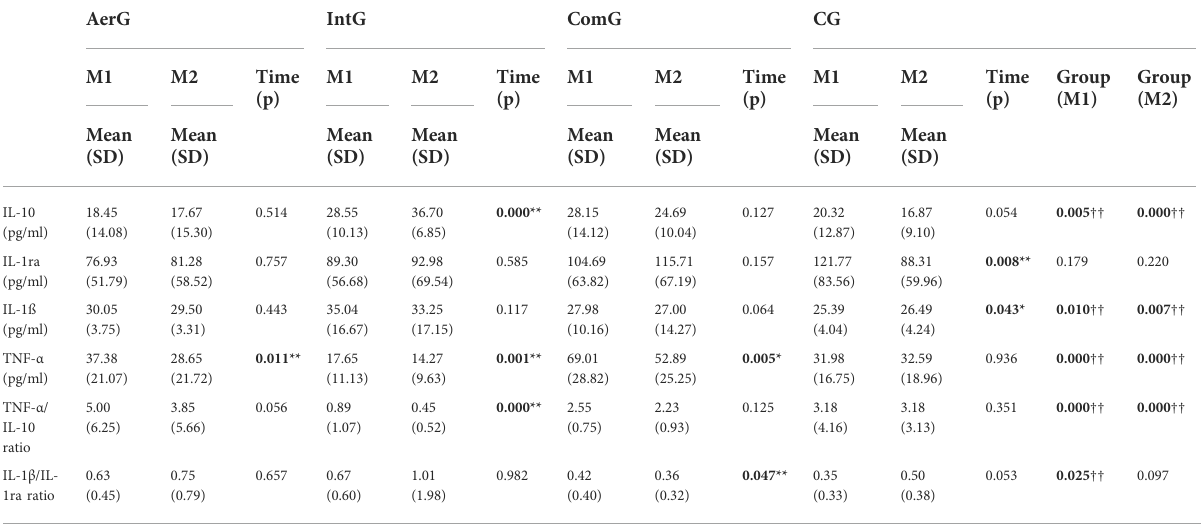
TABLE 3 In fl ammatory markers levels at baseline and after 28 weeks of intervention.